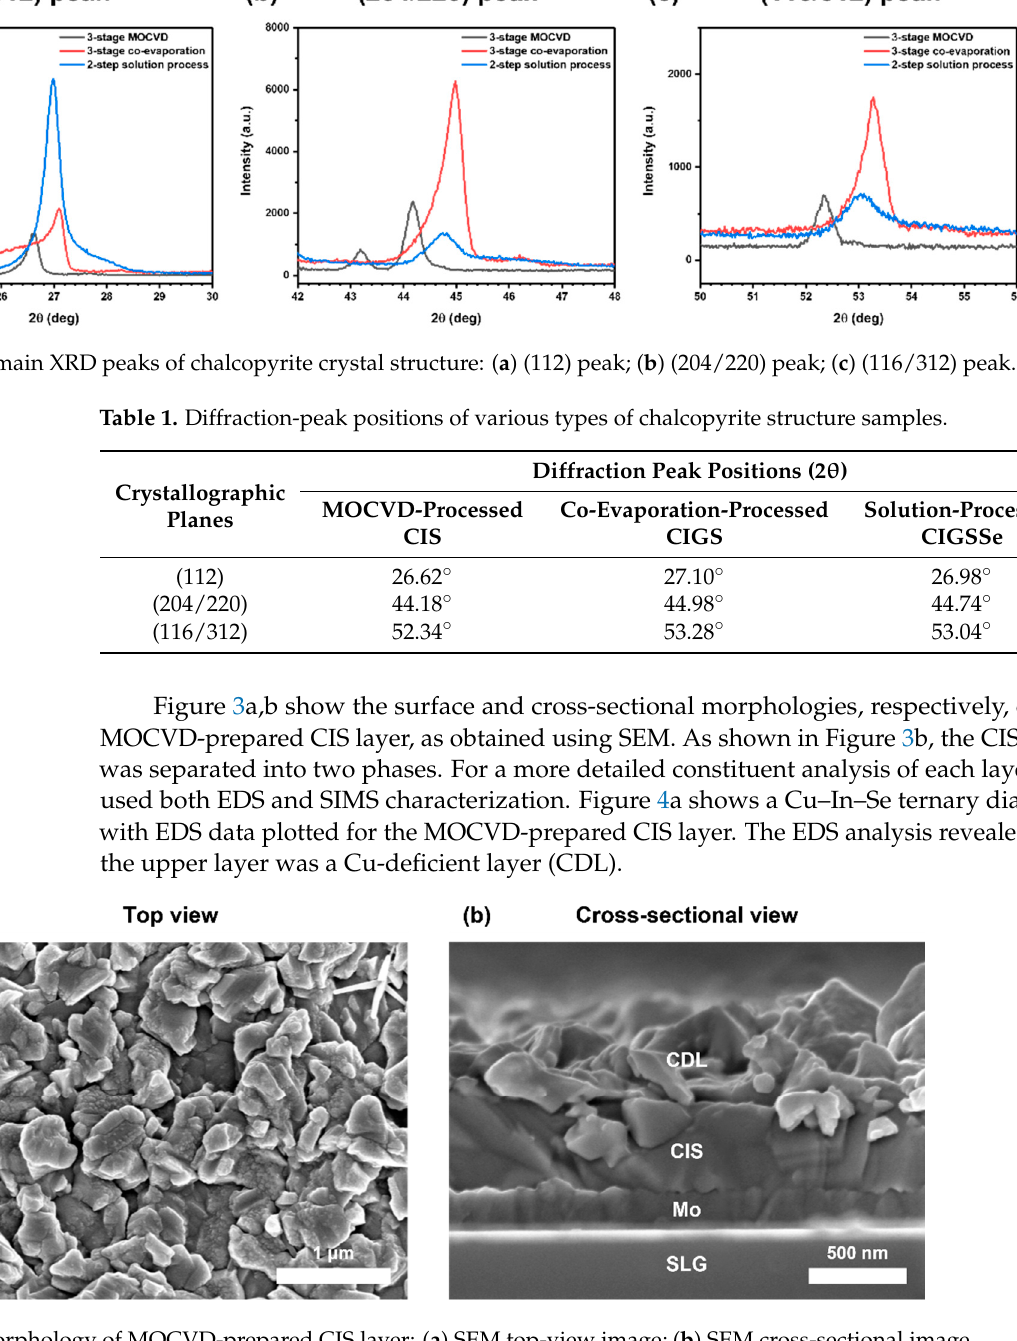
Figure 4. Comparative constituent analysis of the top and bottom layers using ( a ) EDS and ( b ) SIMS.